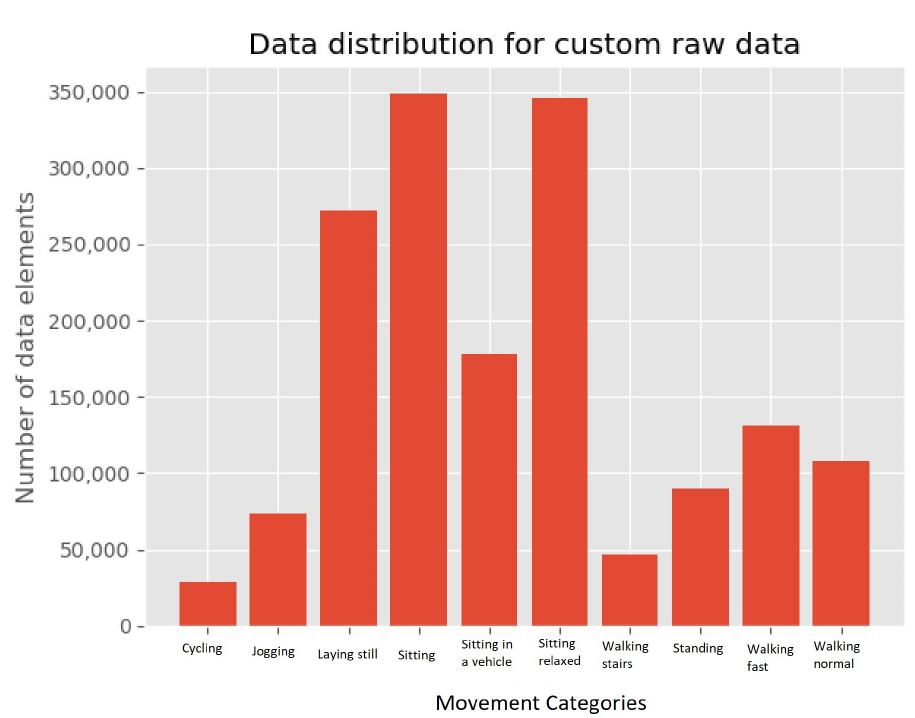
Figure 4. Raw data distribution for the hip-worn